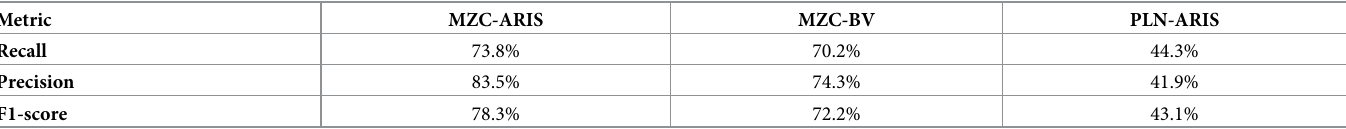
Table 4. Performance metrics for the Mauzac site/ARIS camera (MZC-ARIS), Mauzac site/BlueView camera (MZC-BV) and Port-La-Nouvelle site/ARIS camera (PLN-ARIS) datasets.